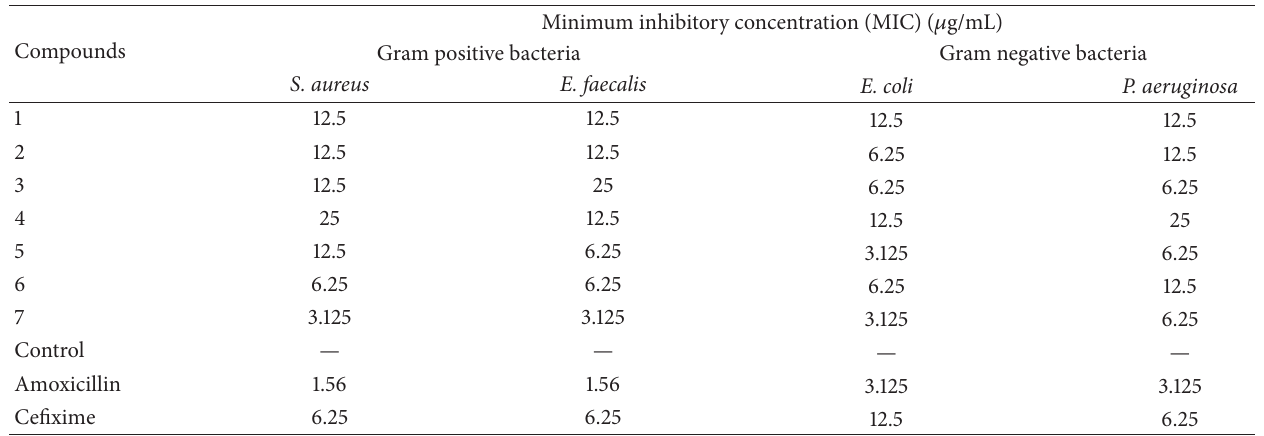
Table 2: Minimum inhibitory concentration (MIC) of the synthesized benzamide substituted Mannich bases against Gram positive and Gram negative